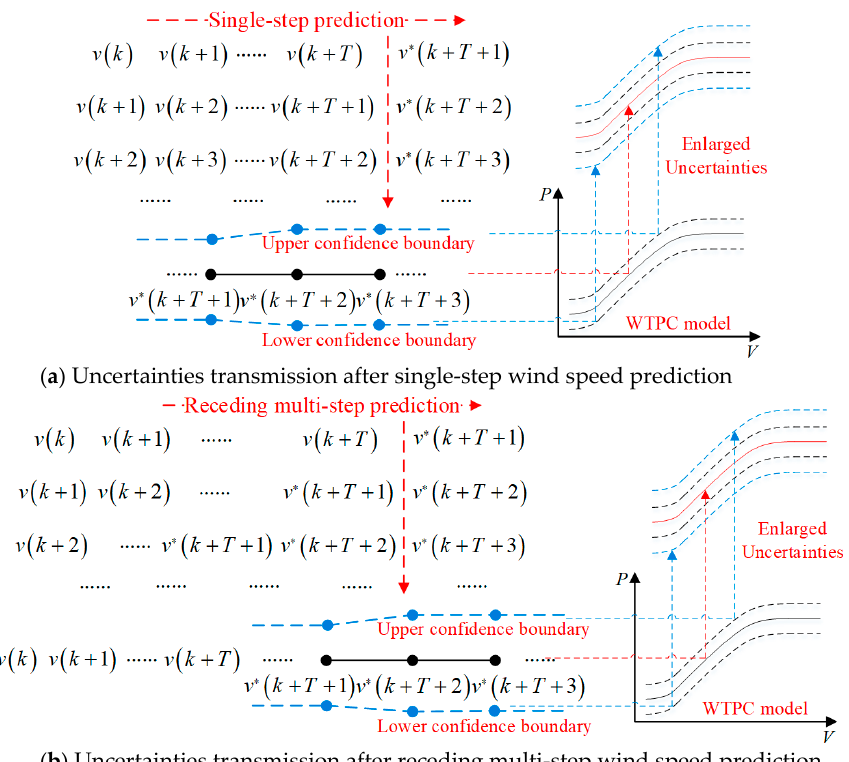
Figure 3. Diagram of uncertainties transmission during wind power prediction.